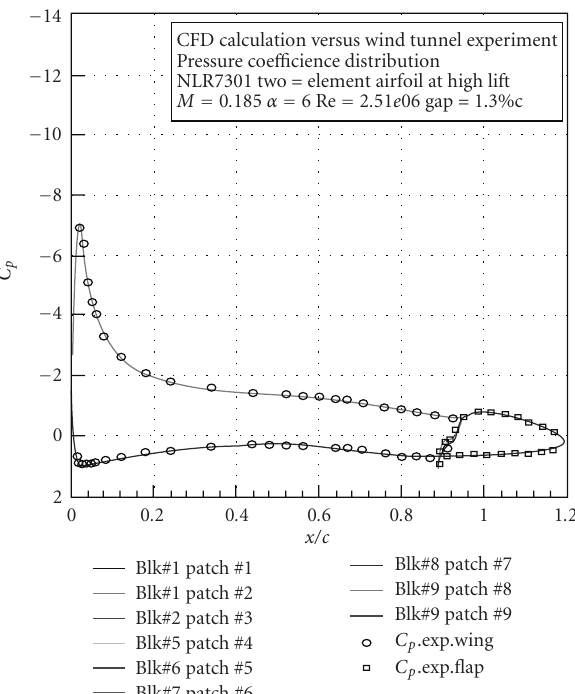
Figure 3: Pressure coe ffi cient distribution by ACTRI for NLR-7301 two elements airfoil (1.3%